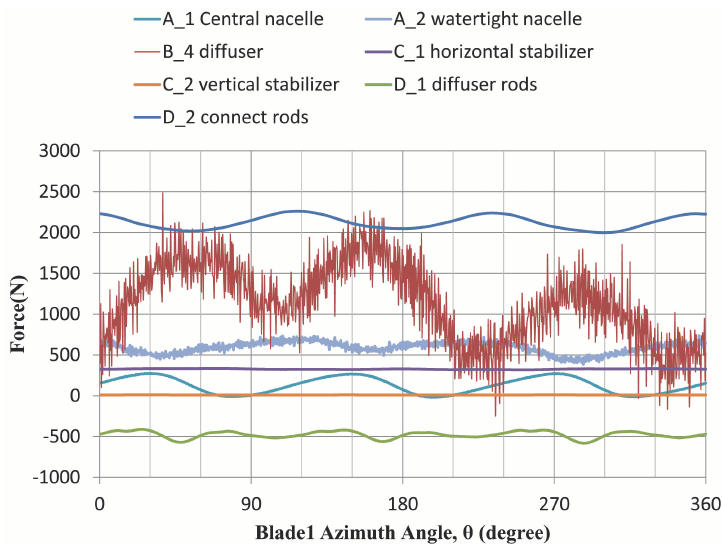
Figure 11. Forces imposed on each turbine component in the z -axis